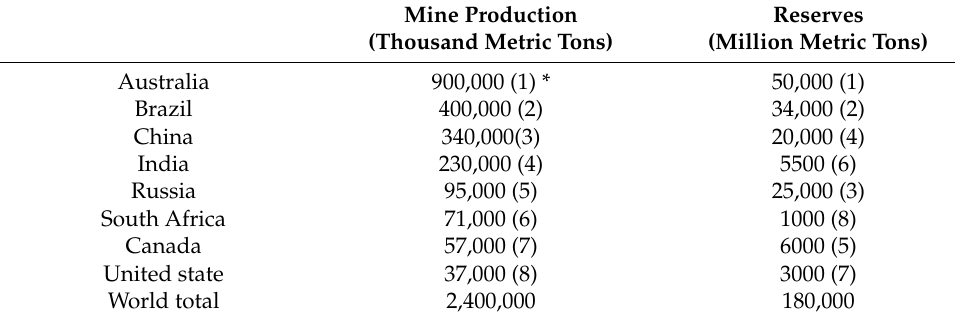
Table 1. World mine production and reserves [1] (USGS, 2021 annual report).